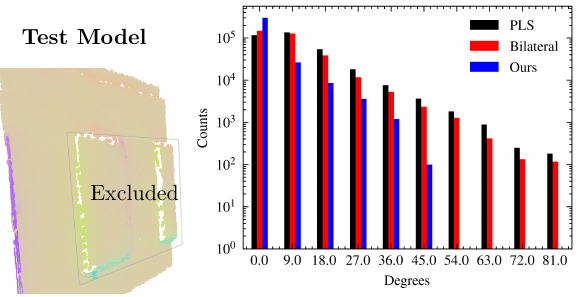
Figure 7. Study of estimated normal variations using the naive bilateral filter and our approach on projecting and recessed brickwork wall pattern, excluding marked